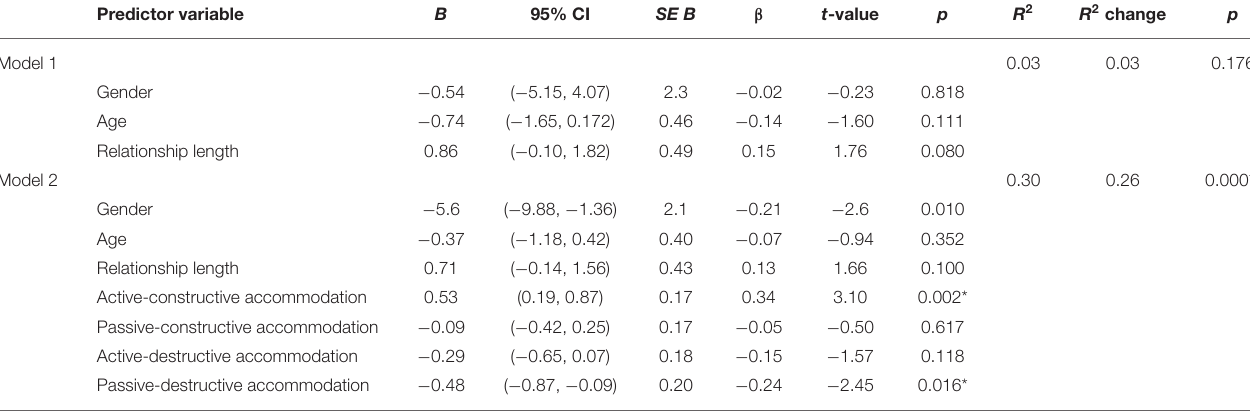
TABLE 4 | Accommodation responses as predictors of relationship satisfaction.